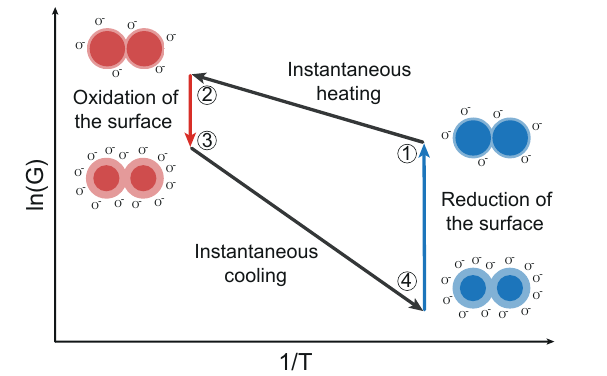
Figure 1. Schematic Arrhenius plot of a MOS sensor and a schematic grain–grain boundary during TCO (Baur et al.,